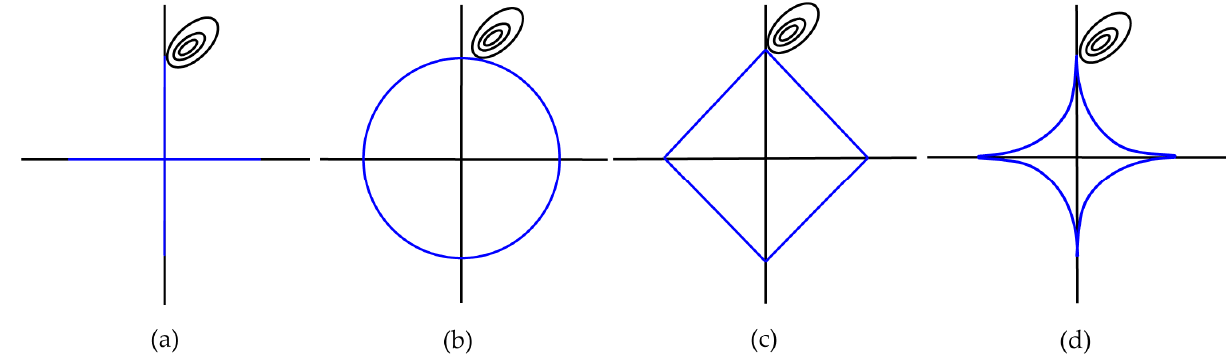
Figure 2. Unit ball pictures for ( a ) L 0 , ( b ) L 2 , ( c ) L 1 and ( d ) L 1/2